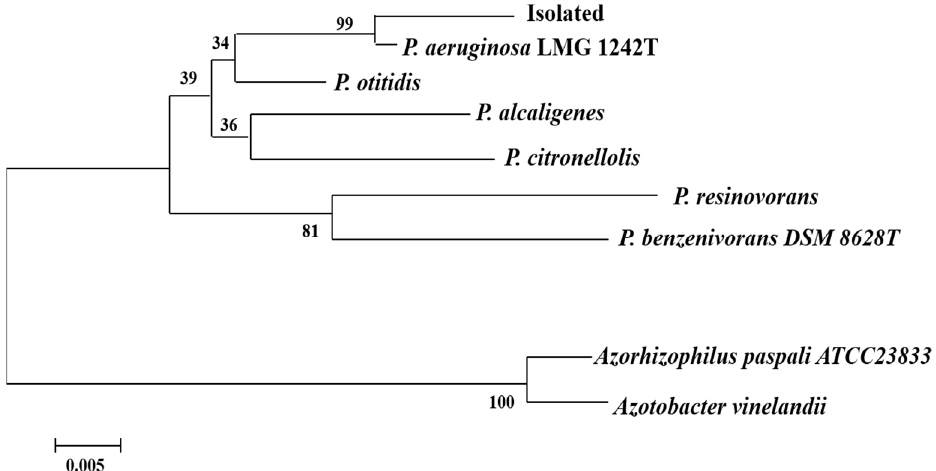
Figure A1. Phylogenetic tree of HD-2 strain.